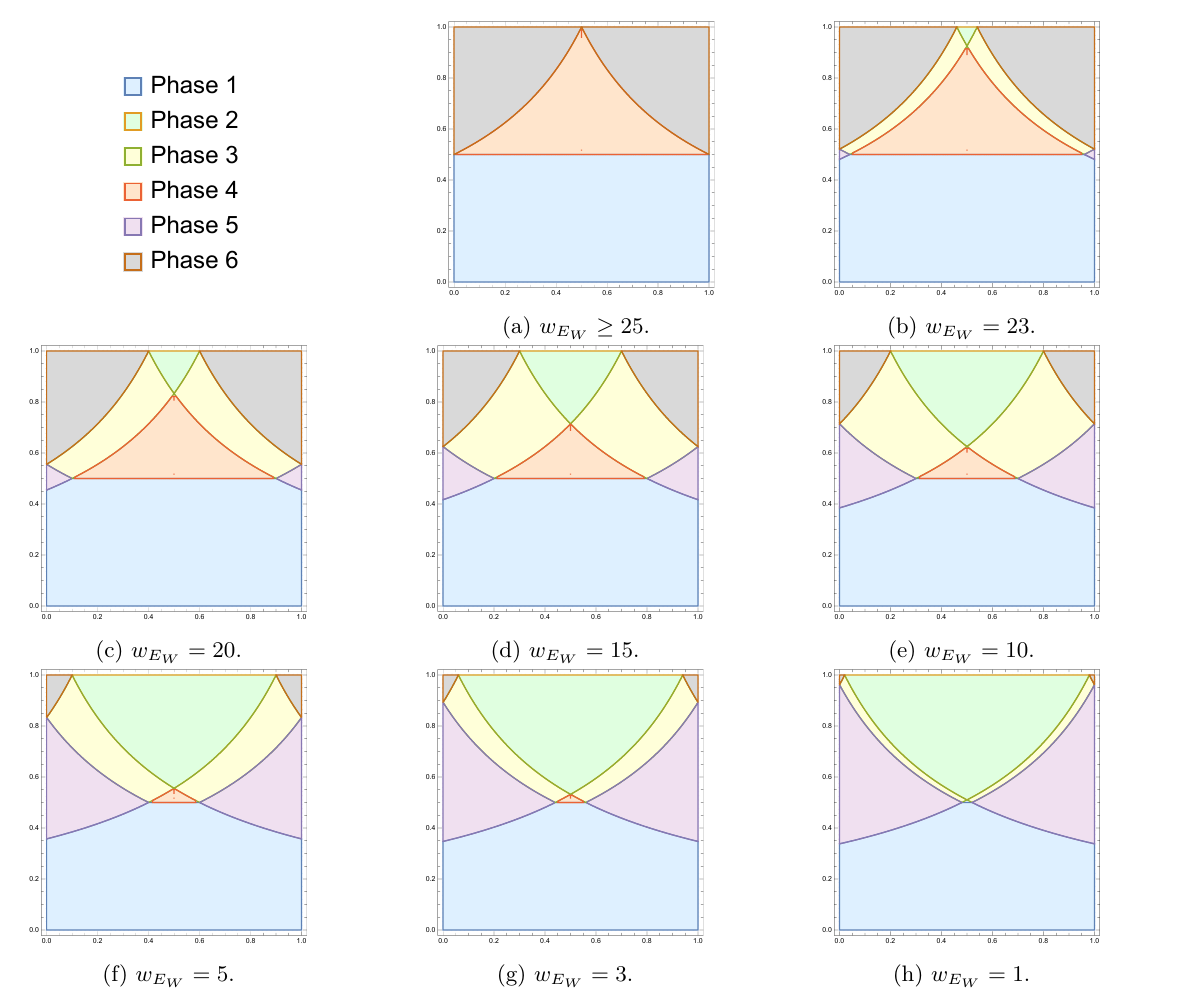
Figure 8 . Plots of different slices of the four-dimensional phase diagram of the two-tensor network. We have taken w and the vertical axis is w A + w B